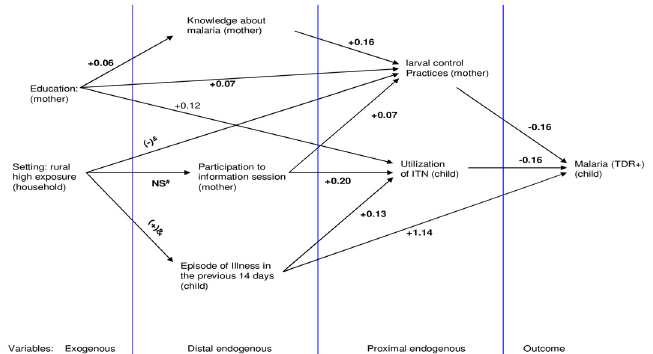
Fig 3. Generalized structural equation model for the relationship between prevention practices and malaria transmission. Legend: & Living in a highly exposed rural area increases the occurrence of illness and decreases vector control practices; # Non-significant statistical association; in bold, standardized regression coefficients that are significantly different from zero; Education, mothers who had gone to school.